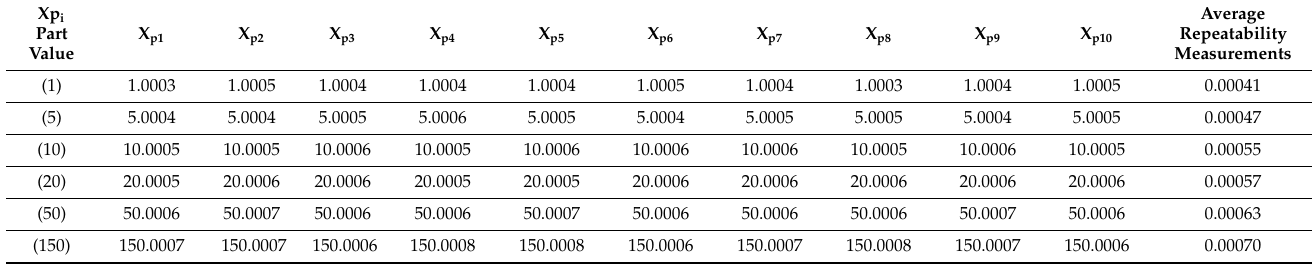
Table 1. Industrial part measurements for repeatability (mm).